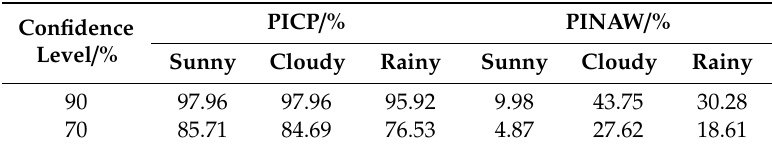
Figure 7. The predicted results under 70% confidence interval. Table 5. Prediction interval indices of proposed model at di ff erent confidence